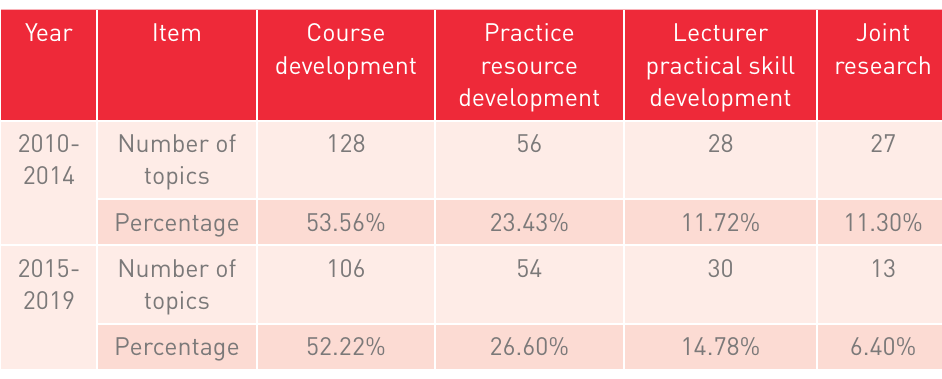
Research topics of UEC papers in Chinese